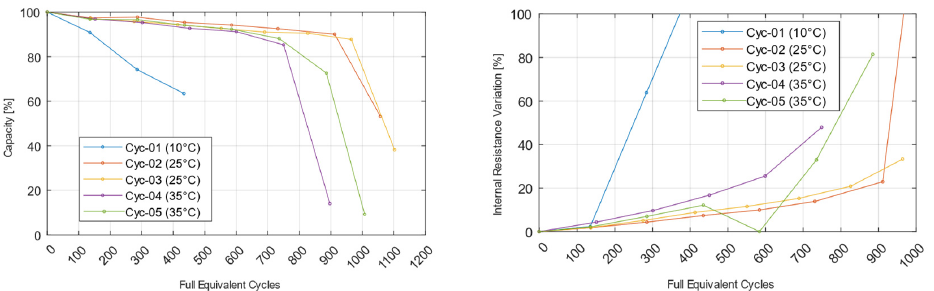
Figure 12. Capacity fade ( left ) and internal resistance increase ( right ) trends for an EV battery illustrating fast degradation once the battery reached approximately 20% capacity fade; capacity measured at 25 ◦ C and C/5 and resistance measured at 25 ◦ C and 50% SOC [33]. Reprinted with permission of the